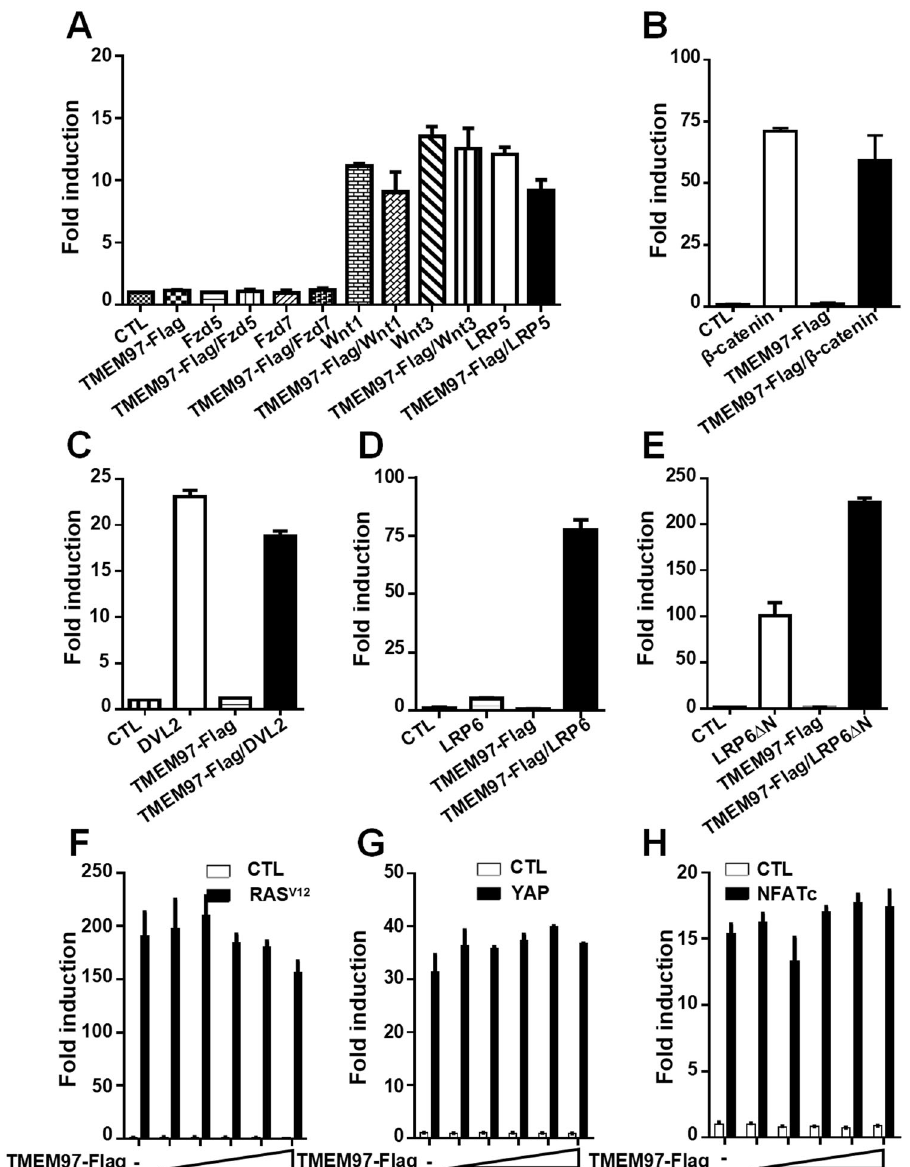
Fig. 2 TMEM97 speci fi cally promotes LRP6-mediated Wnt signaling. A – E The SuperTOPFlash reporter gene was transfected into HEK293T cells together with either TMEM97 expression vector alone or combined with expression plasmids encoding Wnt1, Wnt3, Fzd5, Fzd7, or LRP5 (A). B – E Similar to panel ( A ) except that expression plasmids encoding β -catenin ( B ), DVL2 ( C ), LRP6 ( D ), and LRP6- Δ N ( E ) were used. F HEK293T cells were transfected with an AP1-Luc reporter and empty vector or a constitutively active Ras V12 expression plasmid. G HEK293T cells were transfected with an 8×GTIIC-Luc reporter and empty vector or an expression plasmid for YAP. H HEK293T cells were transfected with an NFAT-Luc reporter and empty vector or an expression plasmid for NFATc. The luciferase values were normalized to β -gal